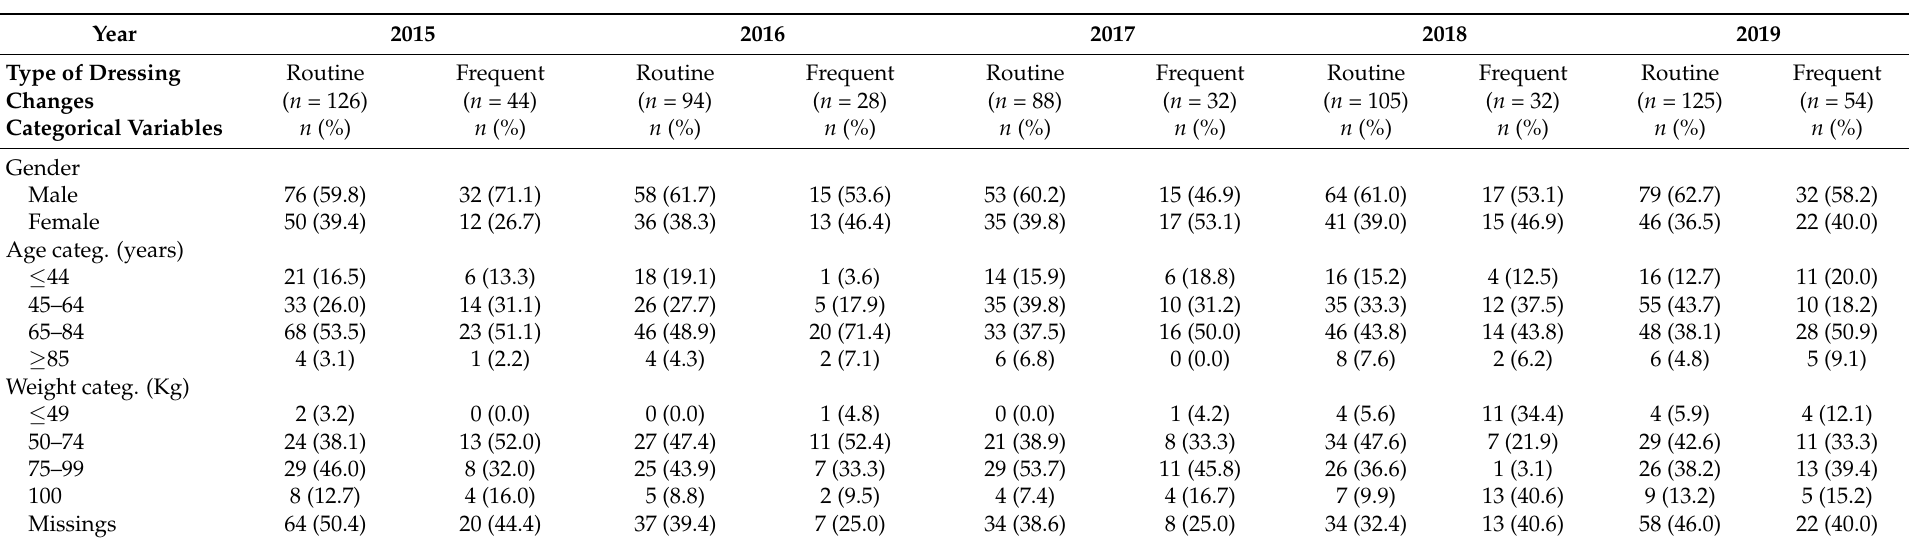
Table A2. Socio-demographic characterization by type of wound dressing changes for each year